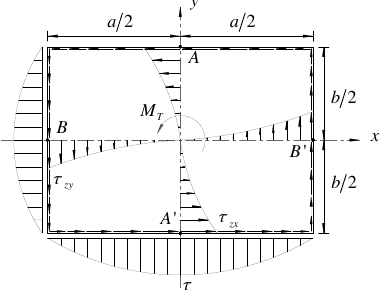
Figure 3. Stress distribution under the torsional load across the prism